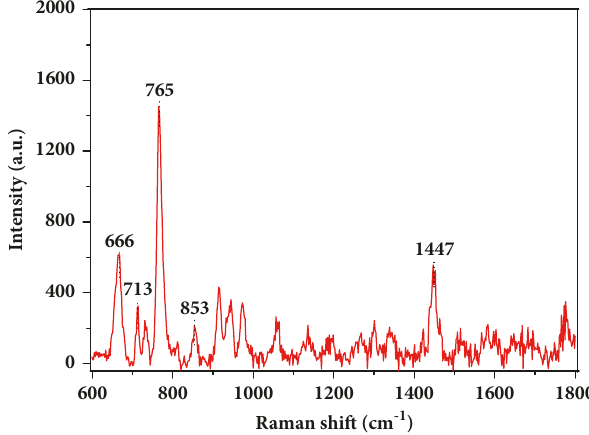
Figure 2: Raman spectra of pure chlormequat chloride powder.